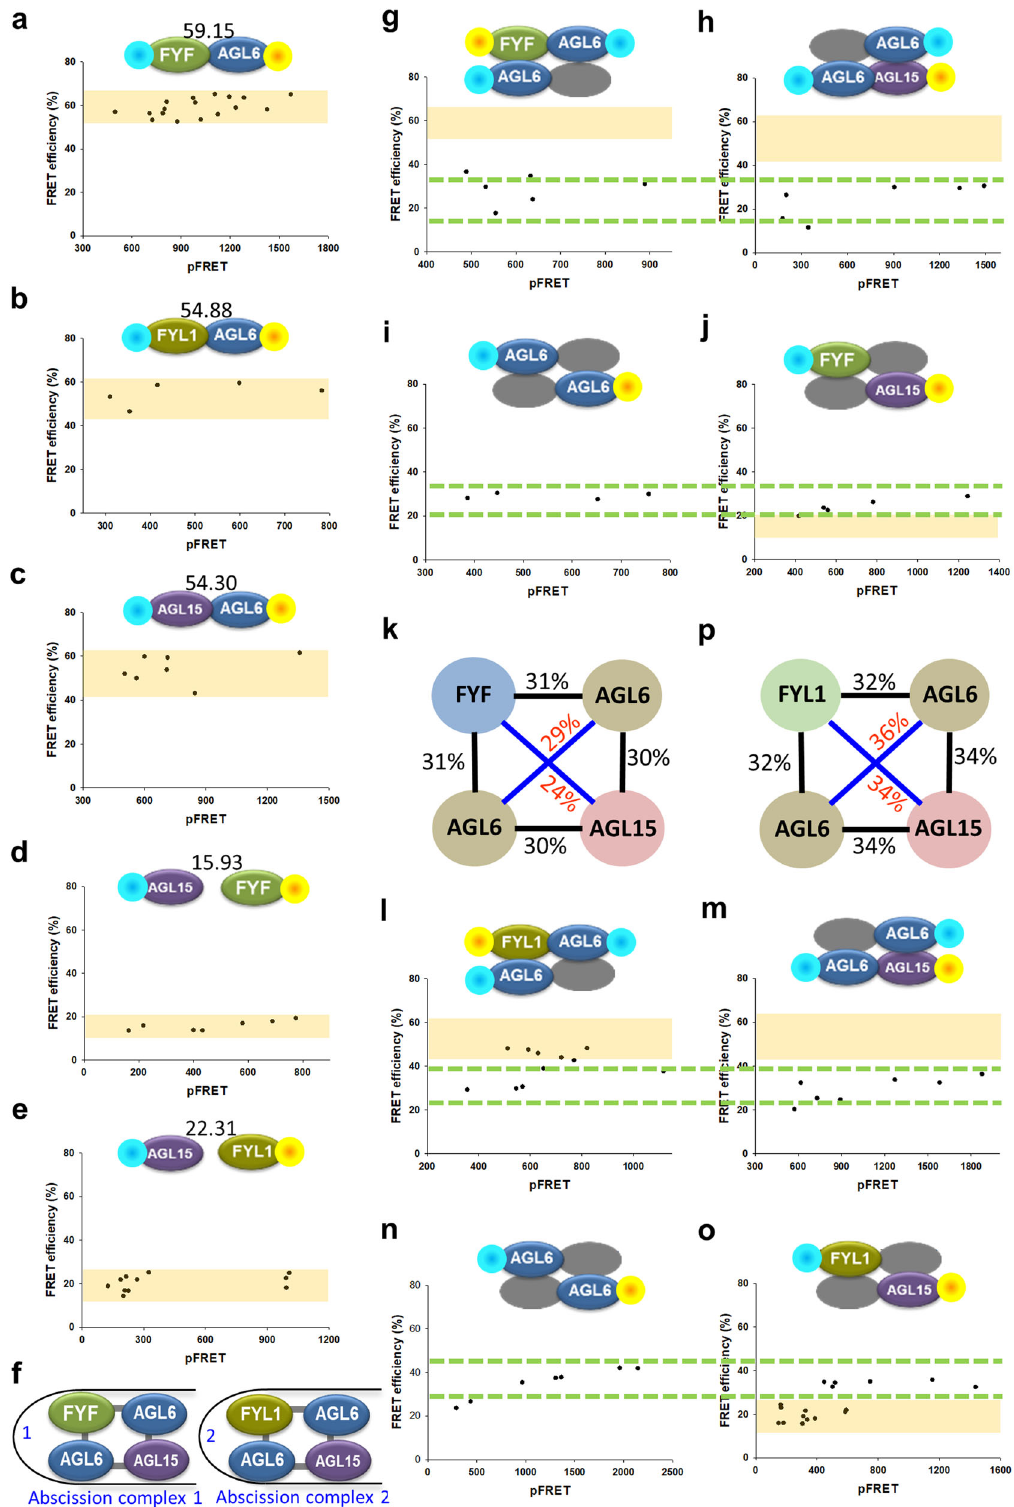
complemented FYF in suppressing fl ower organ senescence/ abscission. Similar to the expression pattern of FYF/FYL2 , higher AGL19/ AGL14/SOC1 expression was observed during early fl ower